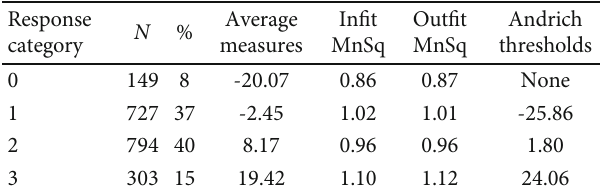
Table 3: Rating scale validity of the